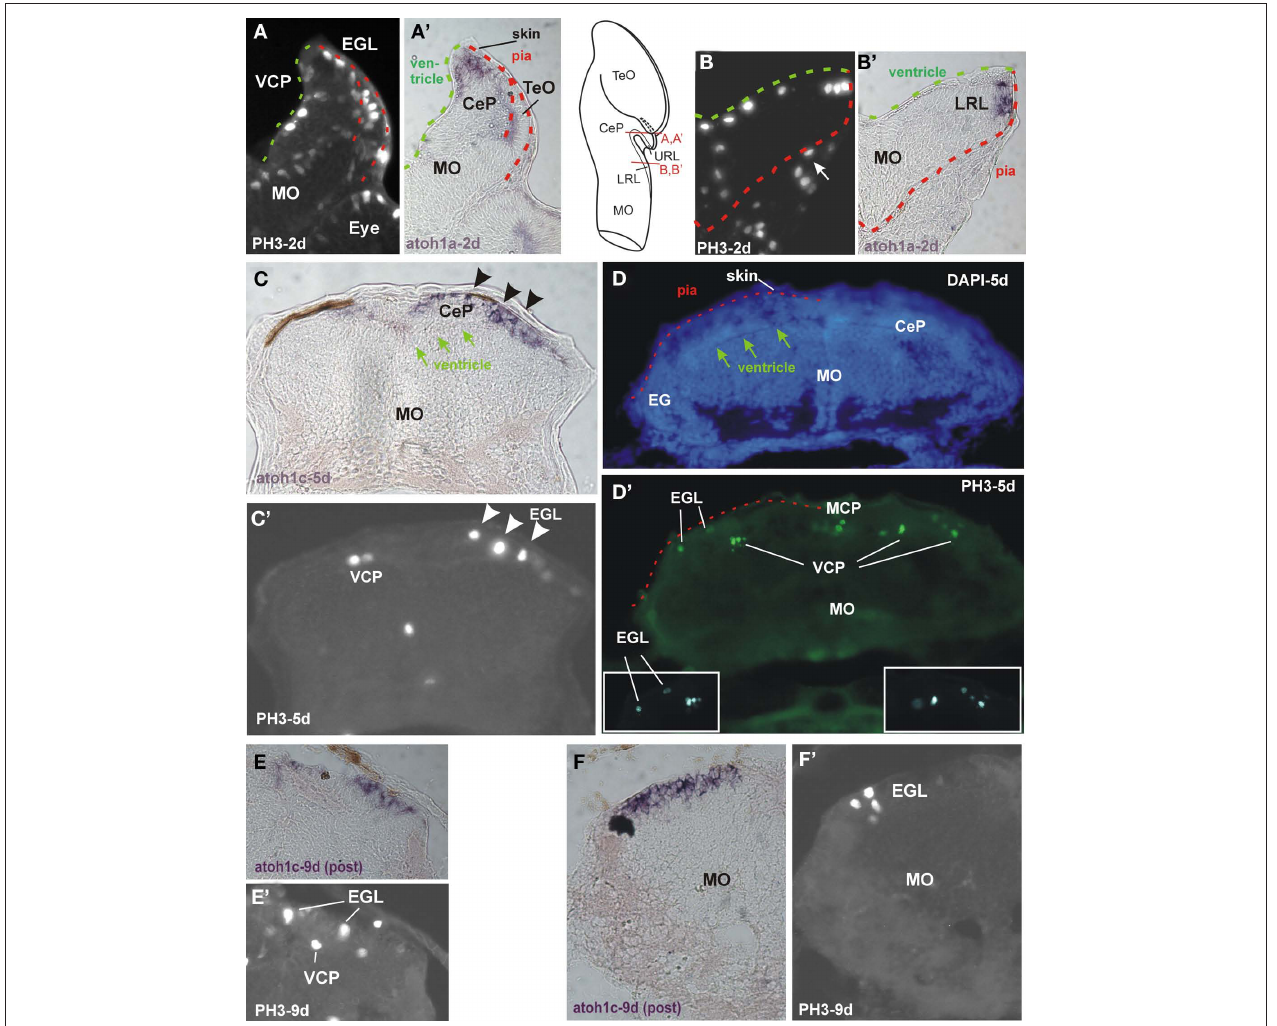
shows PH3 positive cells in atoh1c negative ventral cerebellar proliferation). (D) DAPI stain and (D ′ ) PH3-IHC stain (identical section) demonstrate that proliferative cells are present in ventricular cerebellar proliferation (VCP) and in external granular layer (EGL). Insets show PH3 positive cells in EGL ad VCP at a different focus. Dashed red line indicates pial surface of brain with skin above it. Arrows denote ventricle. (e,e ′ ) and (F,F ′ ) demonstrate that an EGL persists into later larval development, at least 9 days. Note in particular in (F ′ ) how atoh1c expression is at the periphery of the cerebellar plate, that proliferative PH3 cells are restricted to most peripheral EGL and that proliferation is absent in the rest of the hindbrain at that stage. Methodological details will be provided elsewhere. CeP, cerebellar plate; EGL, external granular (or germinative) layer; IO, inferior olive; LRL, lower rhombic lip; MO, medulla oblongata; TeO, tectum opticum; VCP, ventral (or ventricular) cerebellar proliferation (ventricular